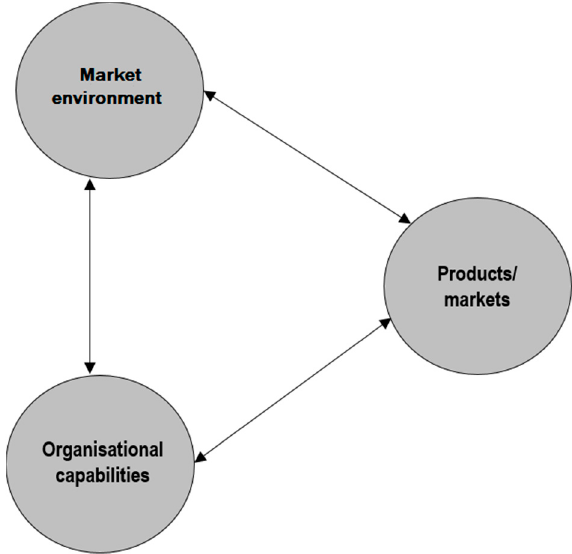
Figure 1. Strategic factors in the private sector.